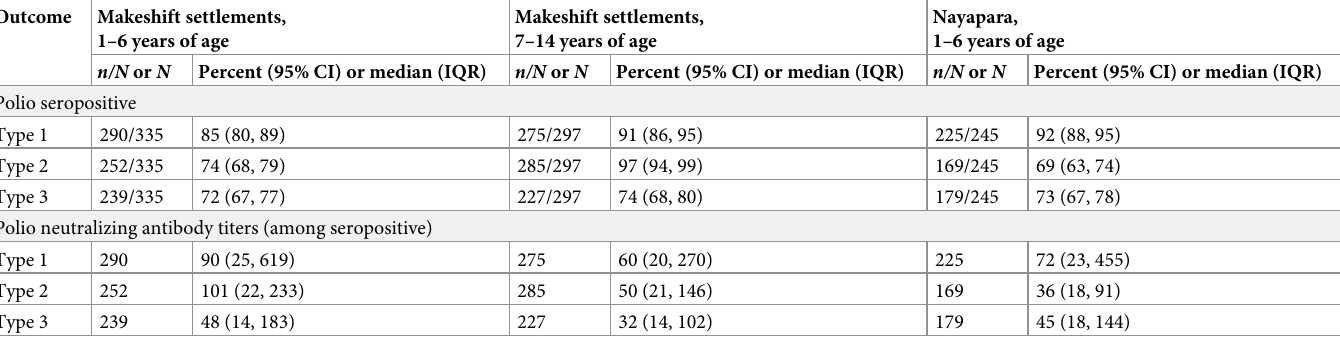
Table 2. Seroprevalence and neutralizing antibody titers to polio by camp/settlements and age group—Rohingya children, Cox’s Bazar, Bangladesh, April–May